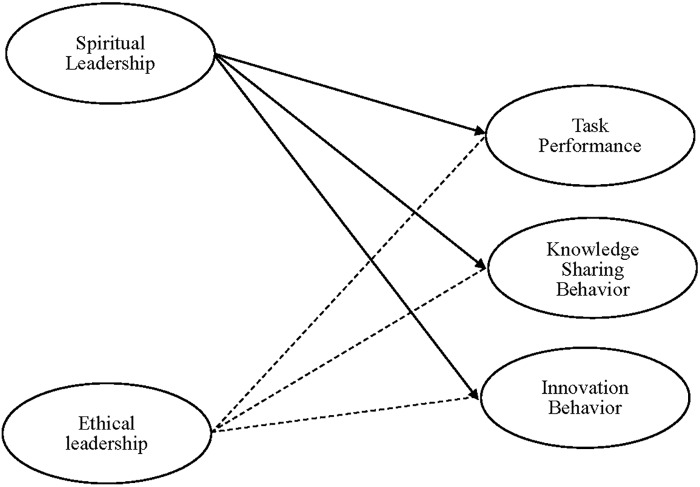
Theoretical model.